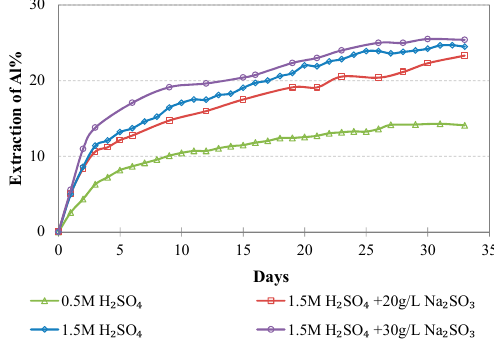
Figure 9. Evolution of % Al extraction vs time during LAI leaching for different tests.